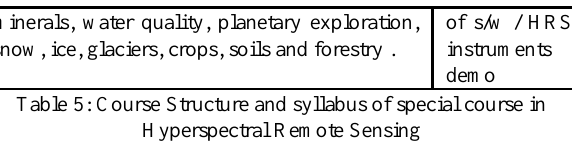
Table 5: Course Structure and syllabus of special course in Hyperspectral Remote Sensing